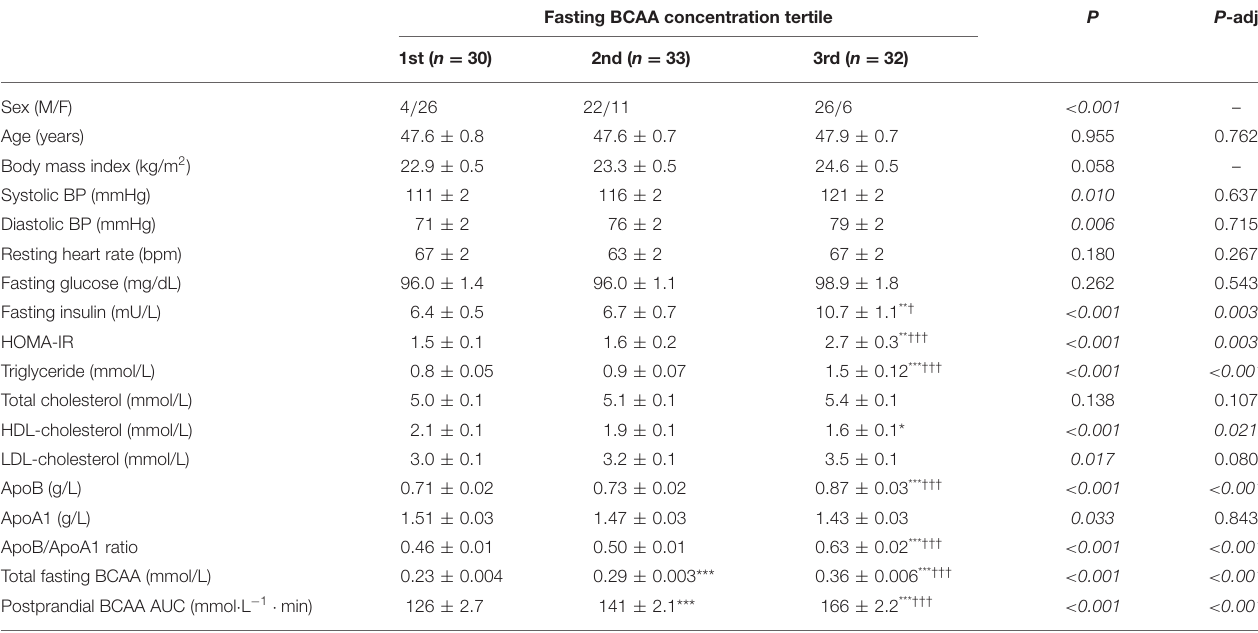
TABLE 1 | Anthropometric characteristics and cardiometabolic parameters of subjects stratified into fasting BCAA concentration tertiles. Fasting BCAA concentration tertile